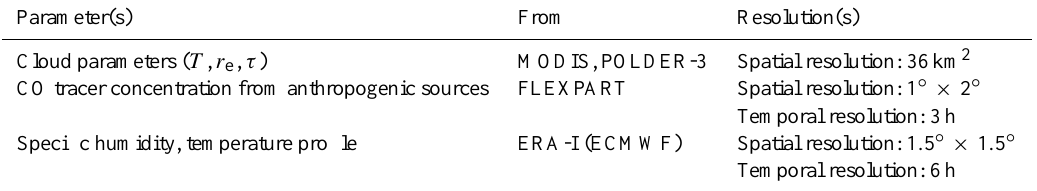
Table 1. Cloud products, pollution tracer, atmospheric reanalysis used in this study with the corresponding spatial and temporal resolution. Parameter(s) From Resolution(s) Cloud parameters ( T , r e , τ ) MODIS,